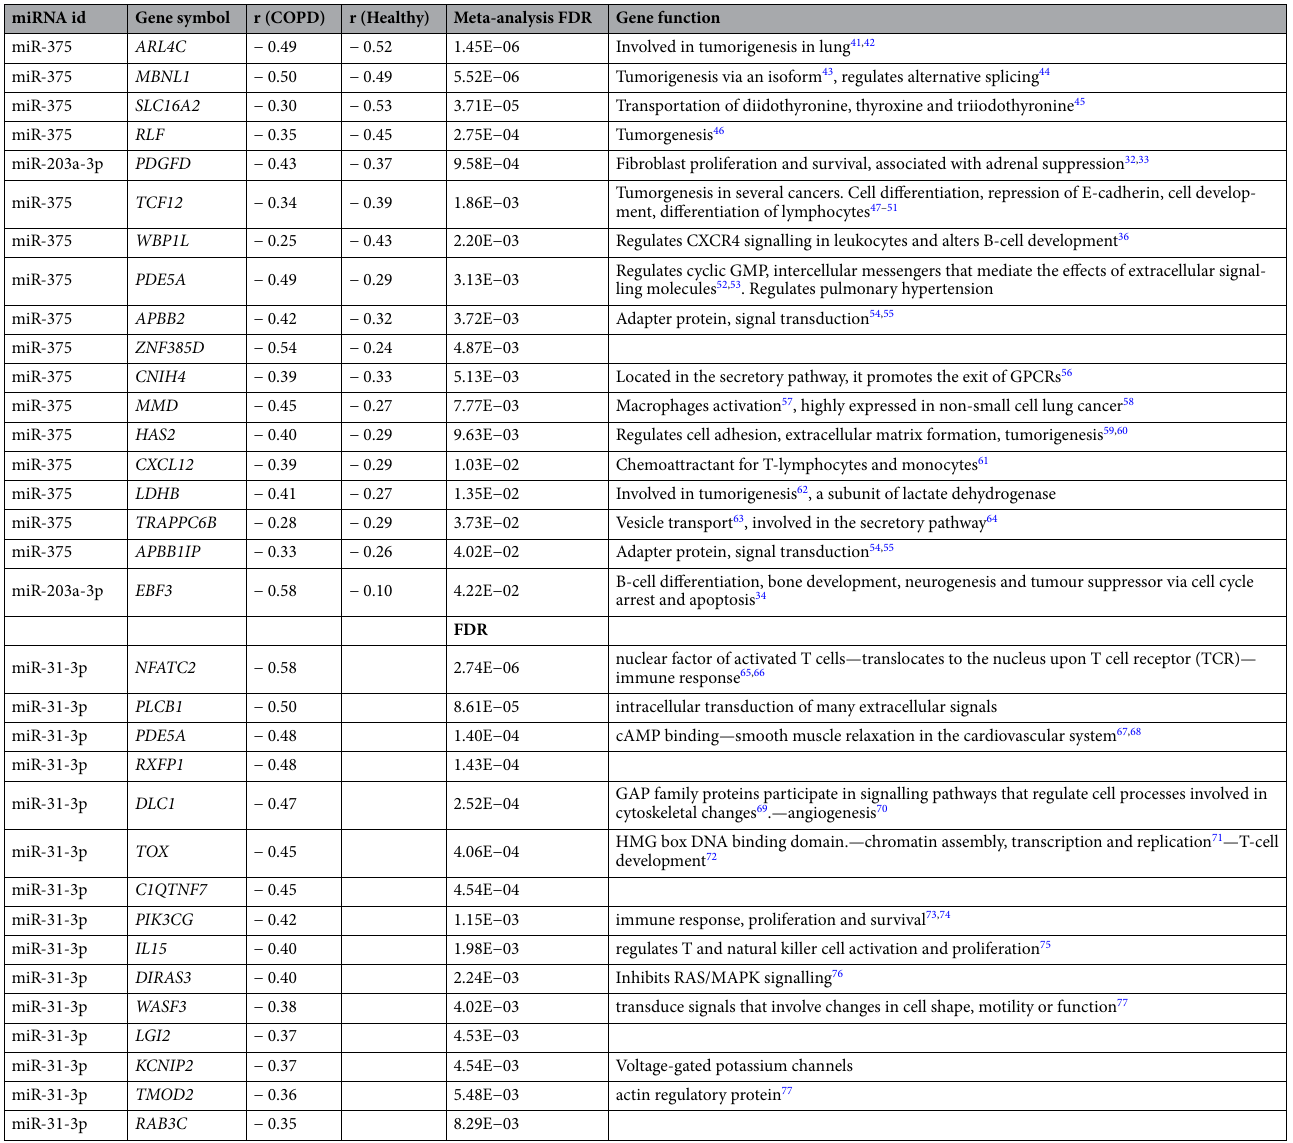
Table 3. Selective literature of predicted target genes that were negatively correlated to miR-203a-3p, miR-375 and miR-31-3p, whilst significant after our meta-analysis (miR-203a-3p and miR-375) or FDR significant (miR-31-3p) after